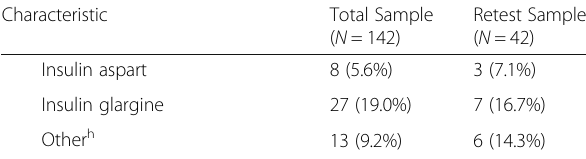
Table 1 Demographic and Clinical Characteristics